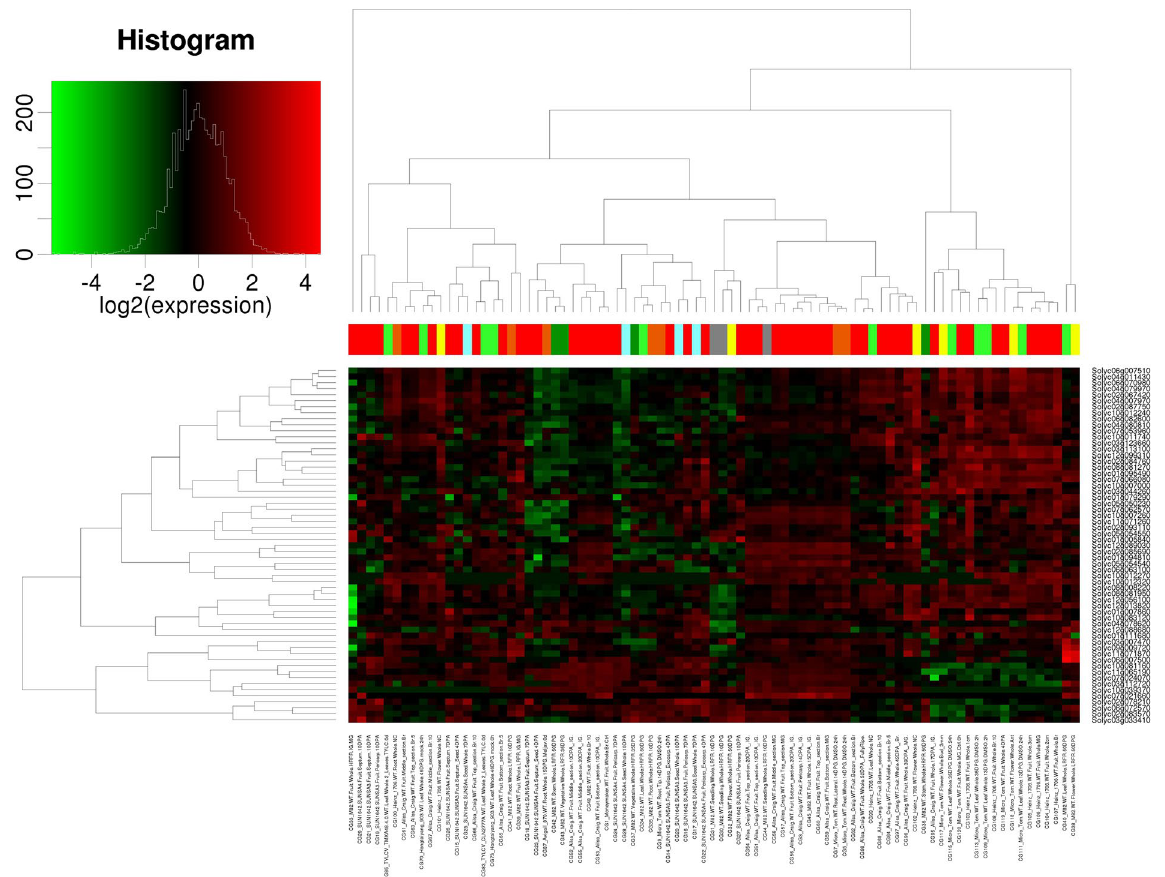
Figure 6. A gene expression profile of 59 tomato E2 enzyme sequences in seed, seedling, root, vegetative, leaf, flower and fruit tissue of Micro Tom, Heinz 1706, M82, Moneymaker, SUN1642, and Alisa Craig cultivars of tomato is illustrated. The normalized gene expression level is represented by a color scale